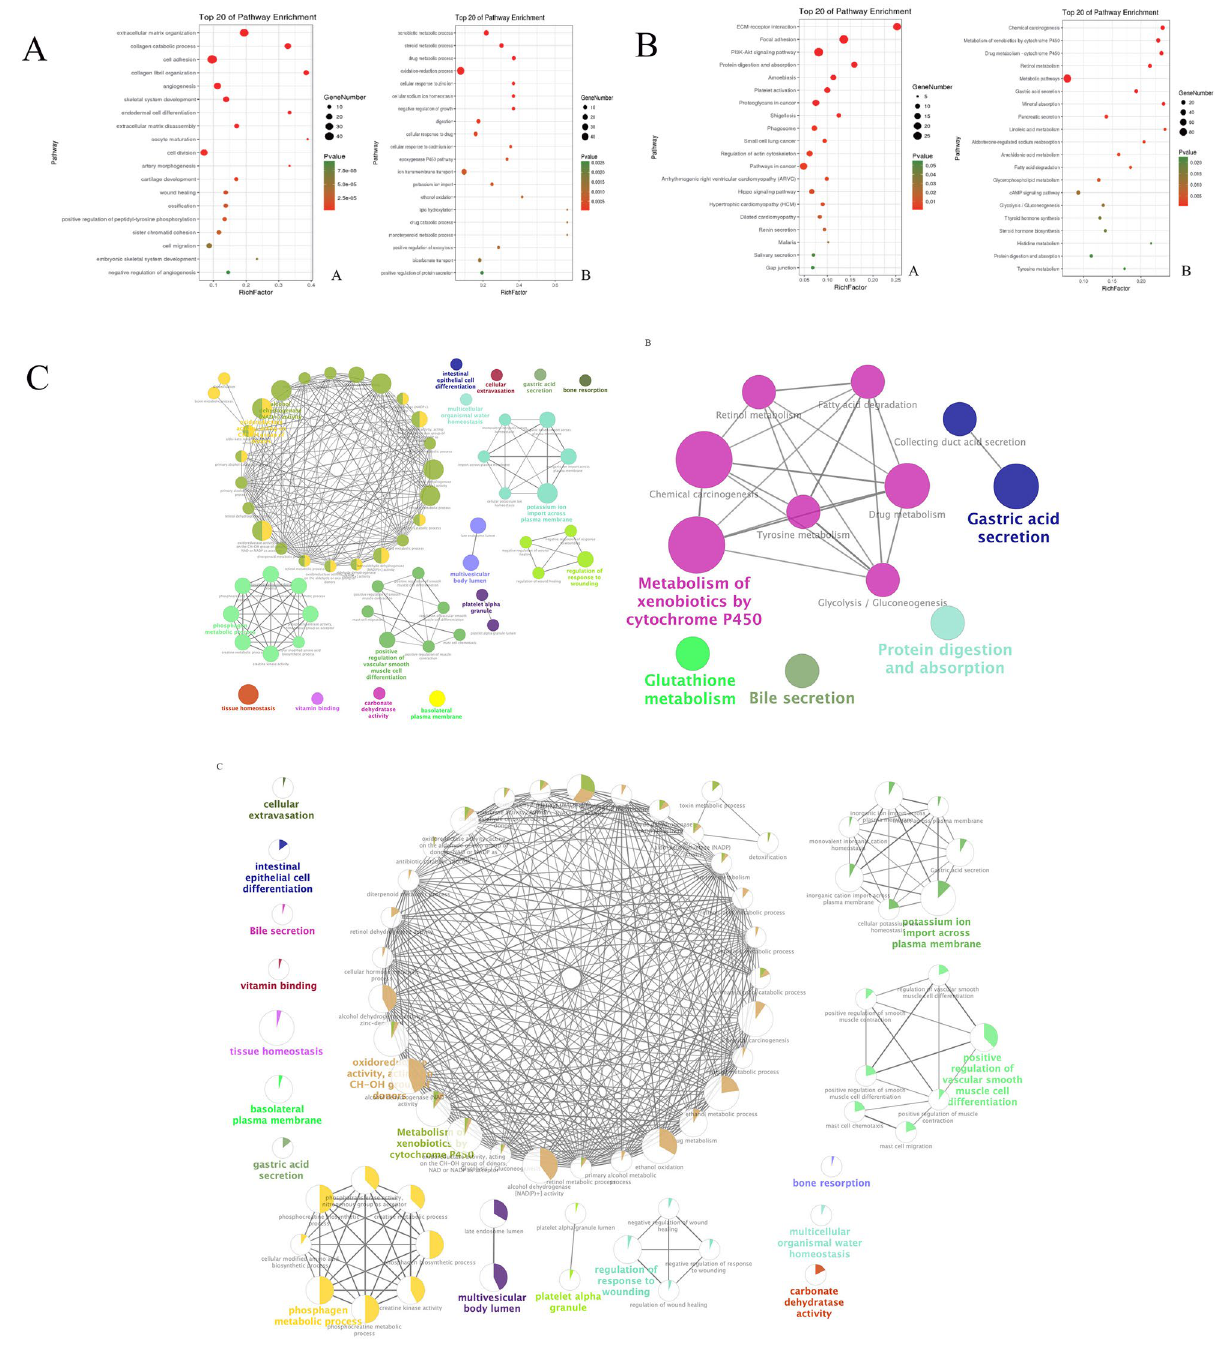
Figure 3. ( A ) The top 20 GO enriched by DEGs (drawn by ggplot2 R package 3.3.2, https:// ggplo t2. tidyv erse. org/); ( B ) The top 20 KEGG pathways enriched by DEGs (drawn by ggplot2 R package 3.3.2, https:// ggplo t2. tidyv erse. org/); ( C ) ClueGO network of pathways for DEGs (drawn by Cytoscape 3.6.0, http:// www. cytos cape. the expression of each pivot gene in different clinical stages of gastric cancer patients. It was found that the patients whose tumors were clinically staged later had higher expression levels of ITGB1 and COL1A2 (P < 0.05) (Fig. 4B). Analysis of the correlation between the expression of the two target genes in normal tissues of gastric cancer patients revealed that the graph was scatterring distributed, there was no obvious correlation. In gastric cancer tissues, the expression of the two is positively correlated, and all points are highly aggregated and linearly distributed (Fig. 4C). It can be speculated that two genes may be involved in the occurrence and development of gastric cancer at the same time. And the expression showed a positive correlation trend. GEPIA was used to analyze the survival correlation of the nodes with higher degree values in the PPI network, and to examine the relationship between the expression level and the survival rate of patients with gastric adenocarcinoma.